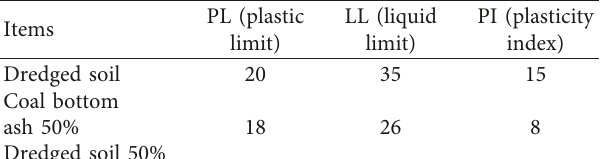
Table 1: Plastic limit (PL), liquid limit (LL), and plasticity index (PI) of raw materials.